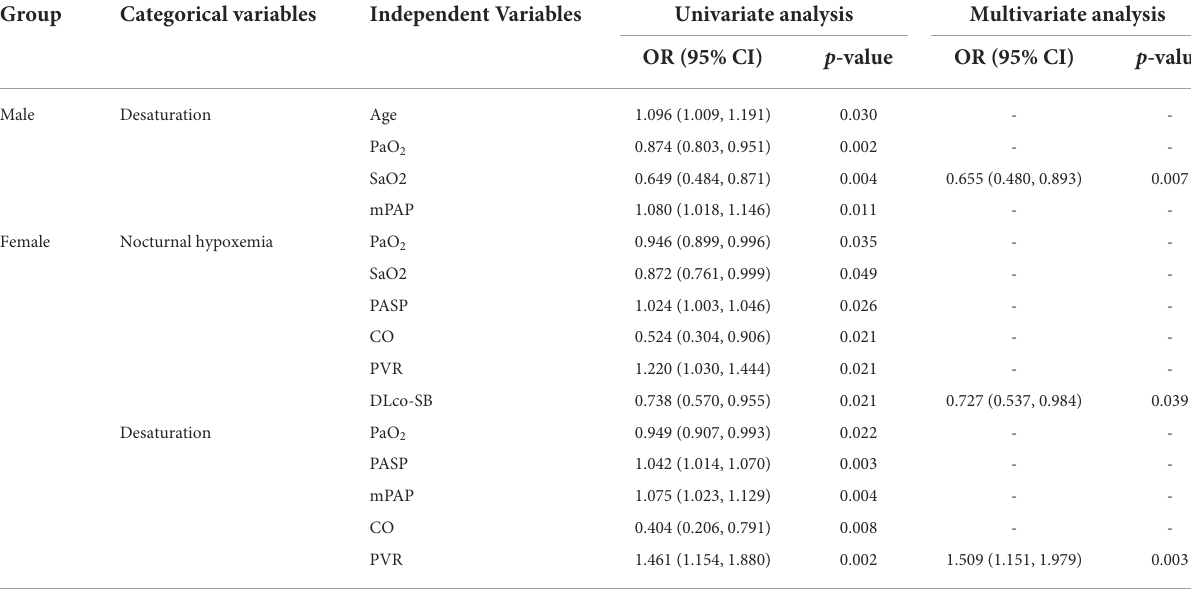
TABLE 2 Predictors of nocturnal hypoxemia and desaturation in male and female patients with CTEPH and CTEPD. Group